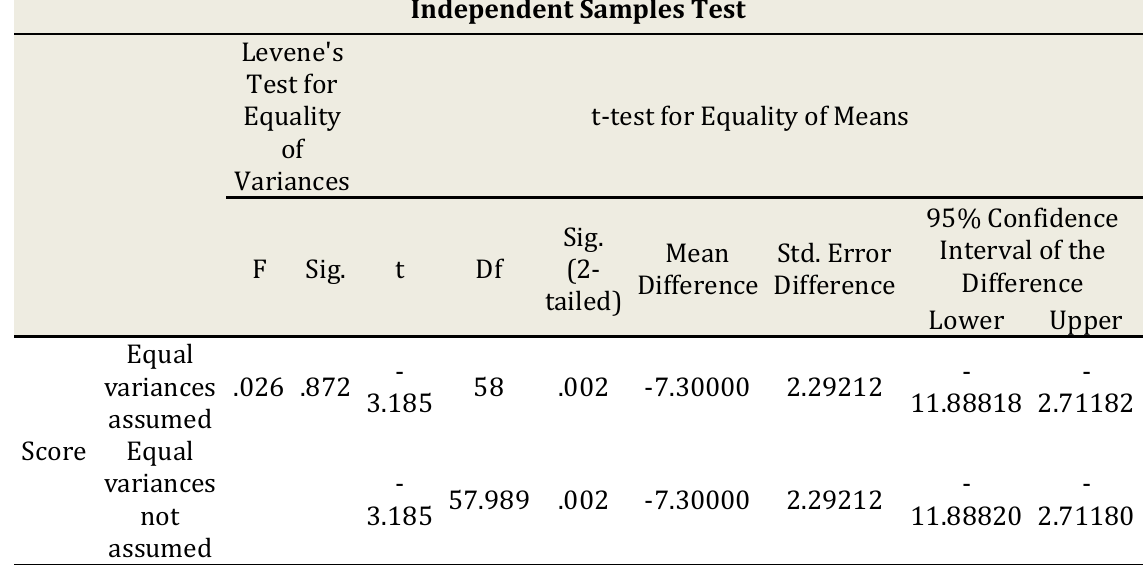
Table 8. The probability value of t-test of post-test in experimental and control